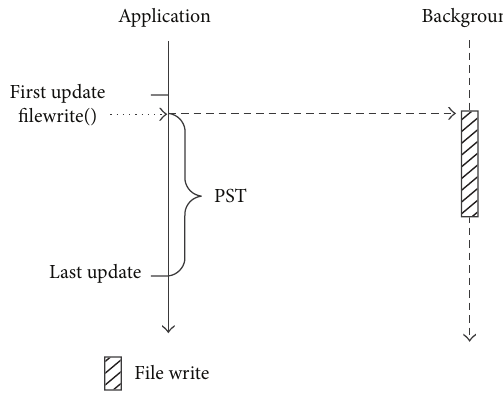
Figure 2: Asynchronous I/O for large volume file.